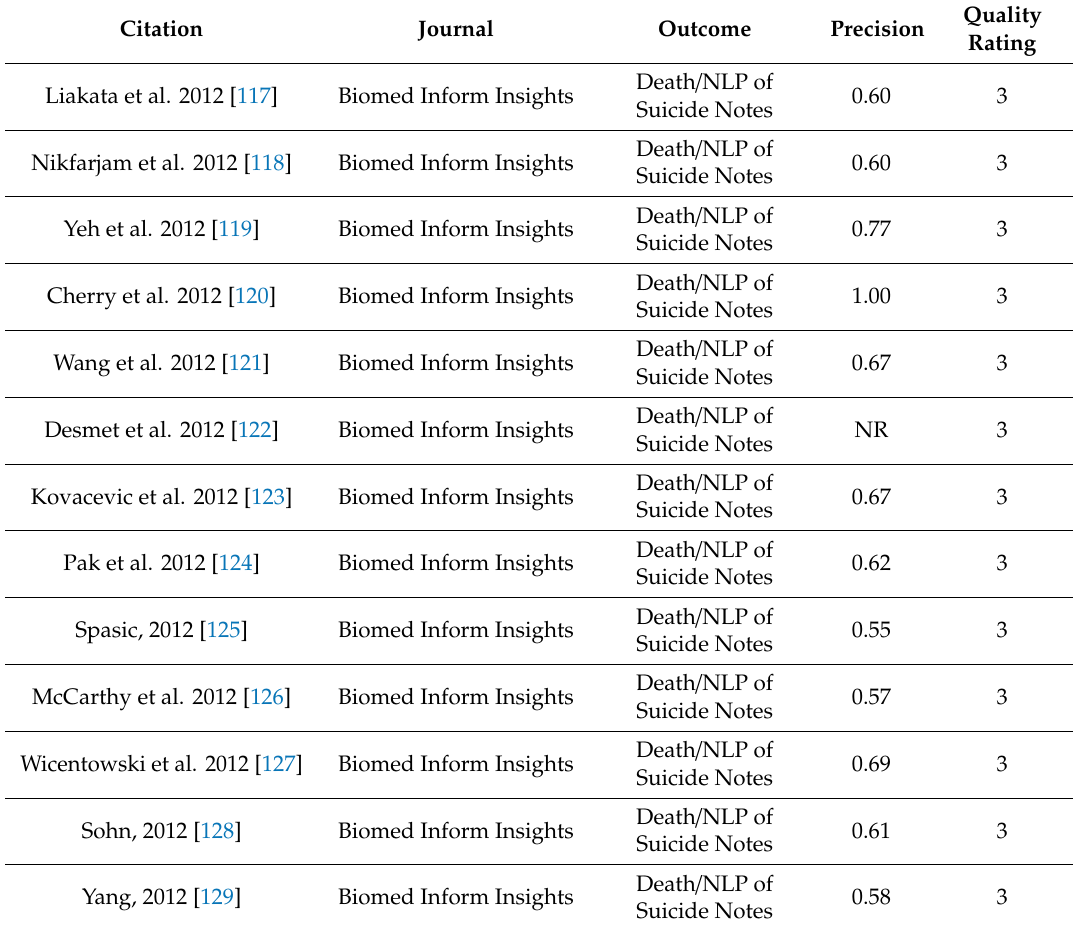
Table 2. Investigations by study subset and ML